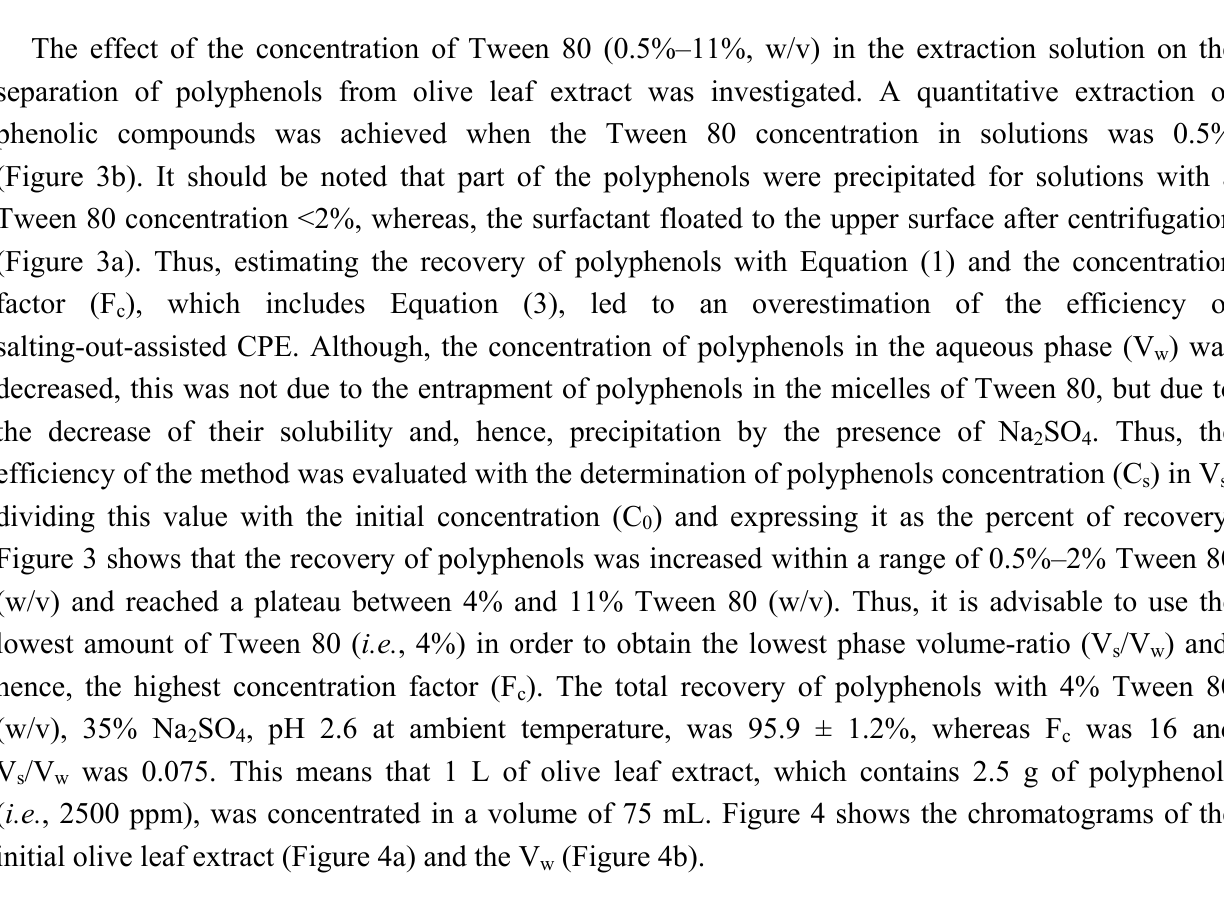
Figure 2. ( a ) The percent of recovery of the total phenols from olive leaf extract as a function of solution pH (settling time 30 min) and ( b ) the percent of recovery of polyphenols from olive leaf extract as a function of the settling time. Conditions: total polyphenols concentration: 2500 ppm; 4% Tween 80 (w/v); 35% Na phenol concentration (ppm) is the sum of the concentration of oleuropein, verbascoside, luteolin- O -7-glucoside, apigenin- O -7-glucoside and hydroxytyrosol in the olive leaf extract,